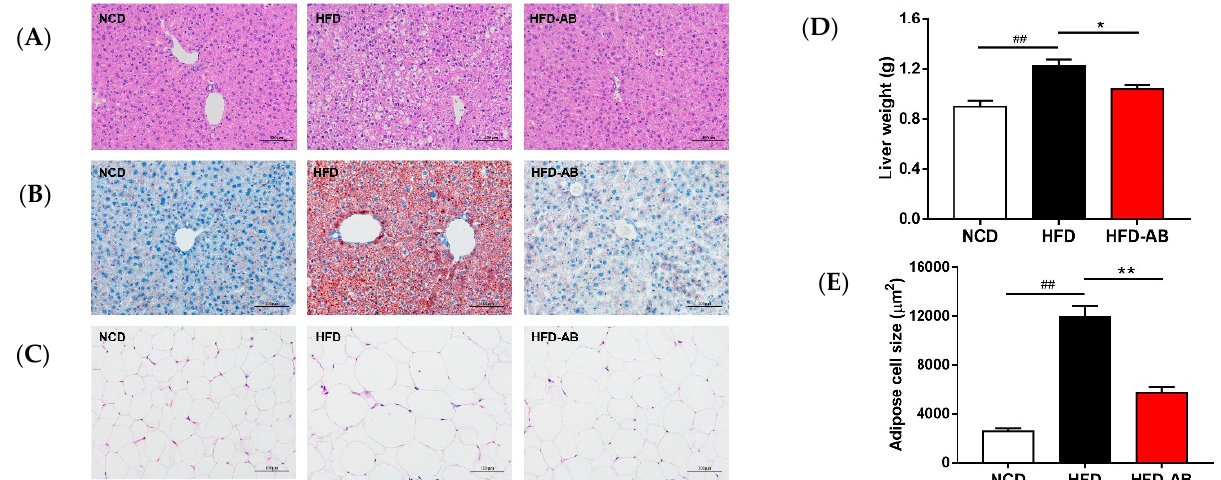
Figure 3. Effects of adzuki bean supplementation on ( A ) H&E staining of liver, ( B ) Oil Red O staining of liver, ( C ) H&E staining of epididymal fat tissue sections, ( D ) liver weight, and ( E ) adipose cell size. Data are shown as mean ± SEM, n = 8 per group. ## p < 0.01, HFD compared with NCD mice. * p < 0.05 and ** p < 0.01, HFD-AB compared with HFD mice. NCD, normal control diet; HFD, high-fat diet; HFD-AB, high-fat diet supplemented with adzuki bean.